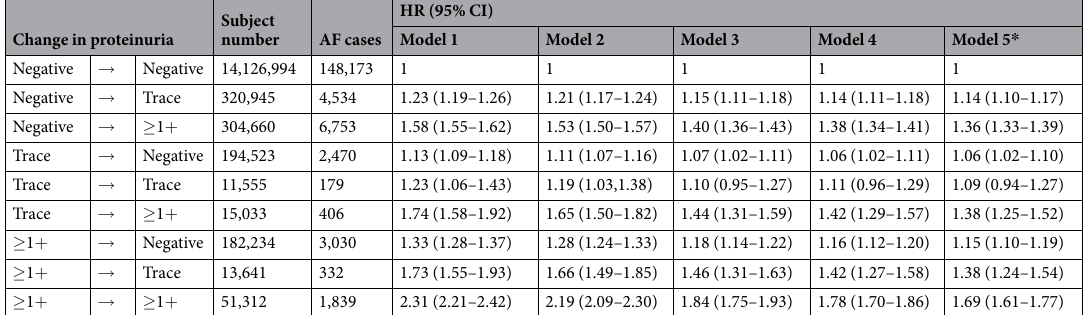
Table 5. Risk of atrial fibrillation according to the follow-up dipstick test. AF, atrial fibrillation; CI, confidence intervals; HR, hazard ratios. Model 1 to 5: Cox proportional models as in Table 4. Covariates adjusted in these models were acquired at the time of the secondary dipstick urine tests. * In model 5, estimated glomerular filtration rate was calculated based on the follow-up health checkup